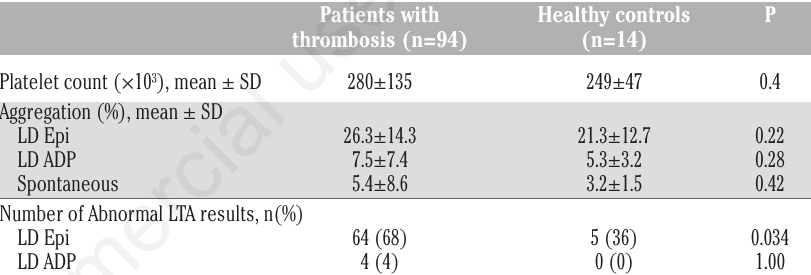
Table 2. Platelet count and platelet aggregometry results in patients with thrombosis and healthy controls.